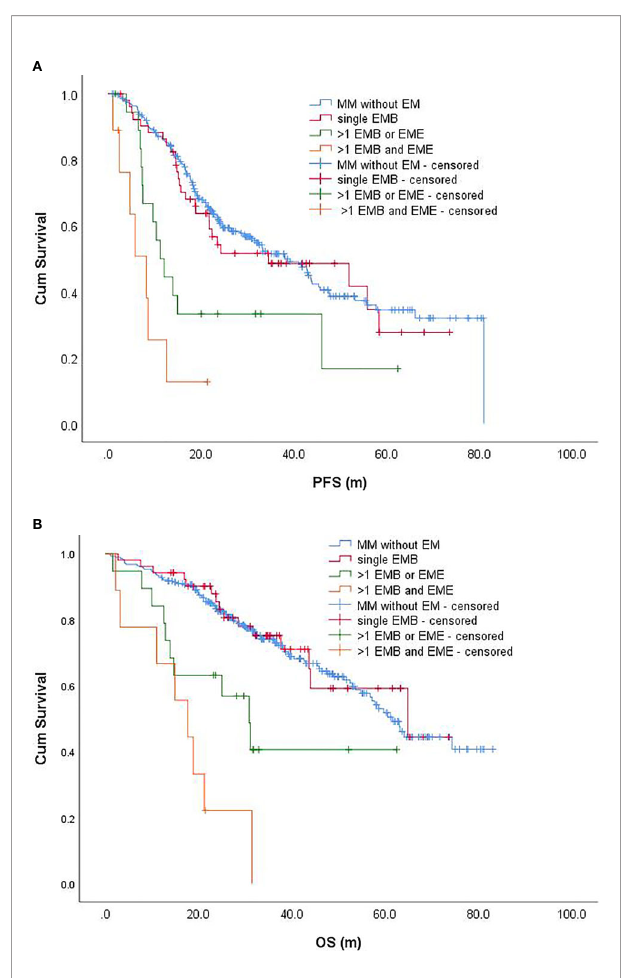
FIGURE 2 | Progression-free survival (A) and overall survival (B) of patients with different EMMs and patients without EM. PFS, progression-free survival; OS, overall